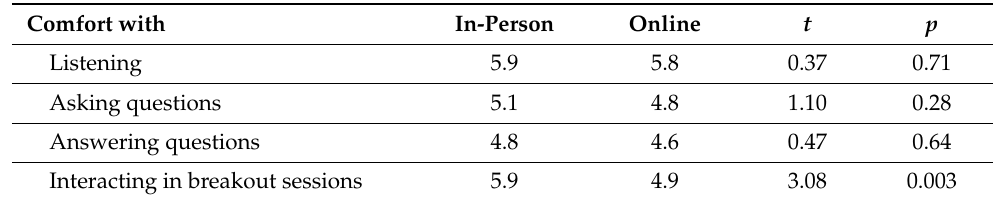
Table 3. Comparisons * within students on mean comfort ratings with traditional in-person vs. online classroom parameters (N =